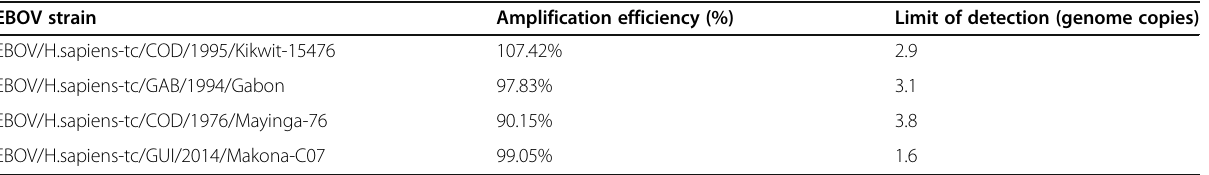
Table 1 Ebola virus ( Zaire Ebolavirus ) strain comparison EBOV strain